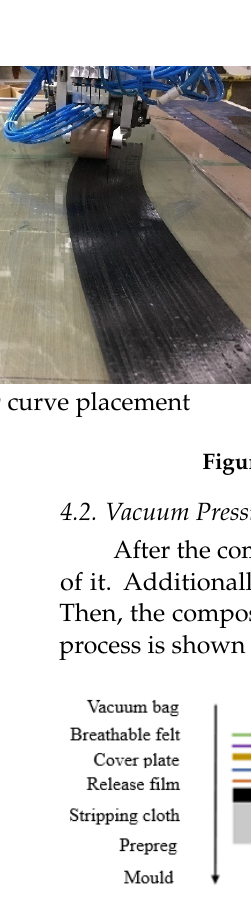
Figure 8. Prepressing process.